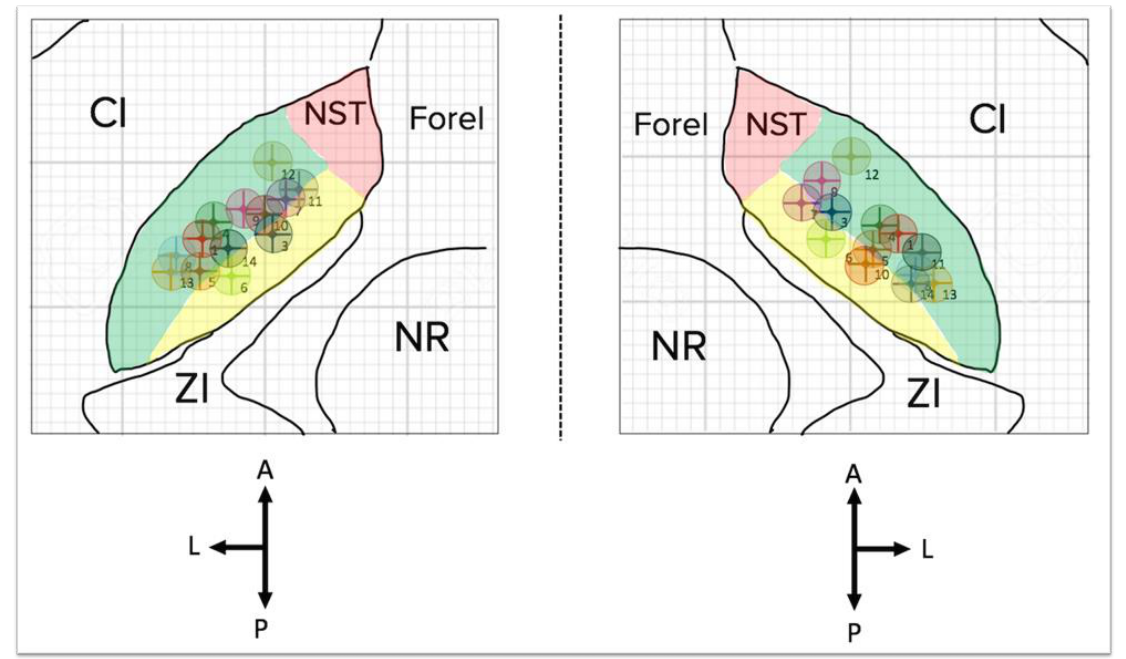
Figure 6. Map of the lead positionings of the 14 patients inside the SubThalamic Nucleus, bilaterally. NST: SubThalamic Nucleus (Nucleus SubThalamus); CI: internal capsule; ZI: zona incerta; NR: Nucleus ruber (red nucleus) of Luys; A: anterior; P: posterior; L: lateral. Drawn following [26 – 29].